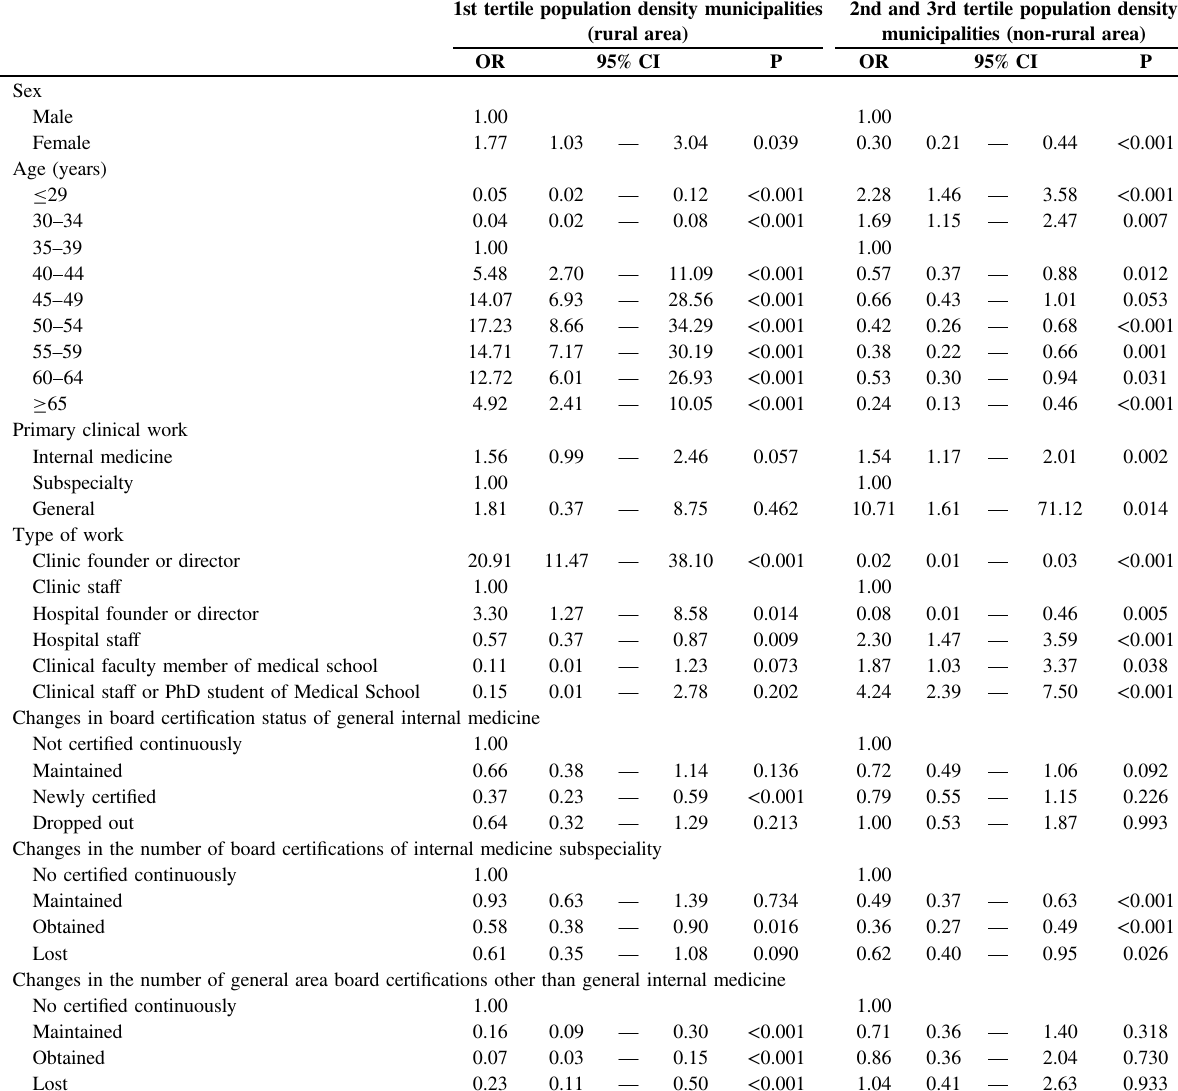
Table 3 ORs for working at fi rst tertile PD municipalities (rural area)